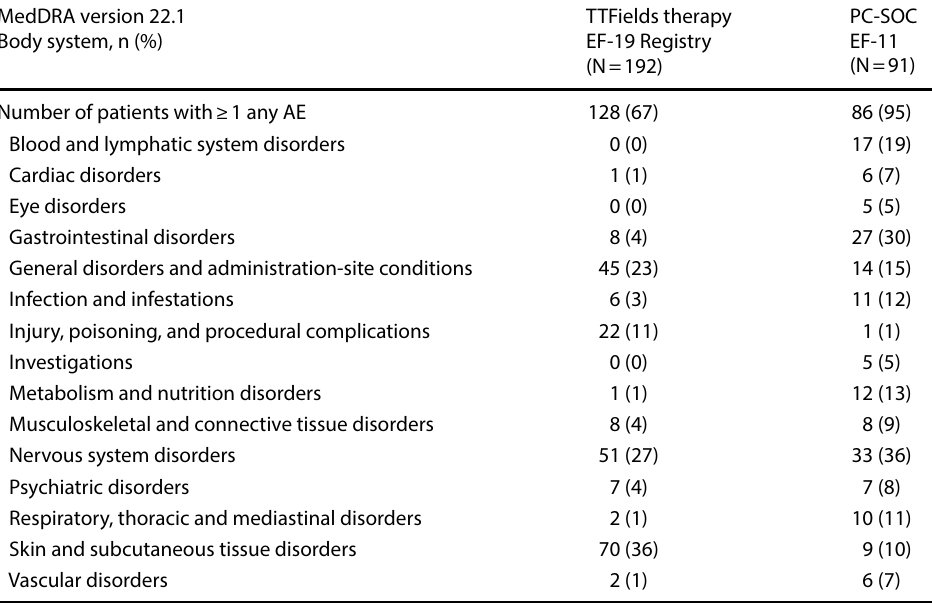
Percent values have been rounded to nearest integer AEs adverse events; MedDRA Medical Dictionary for Regulatory Activities; PC-SOC physicians’ choice stand- ard of care; TTFields Tumor Treating